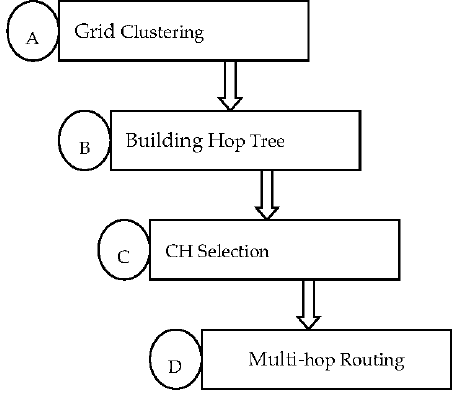
Figure 2. Weighted grid clustering routing design diagram.